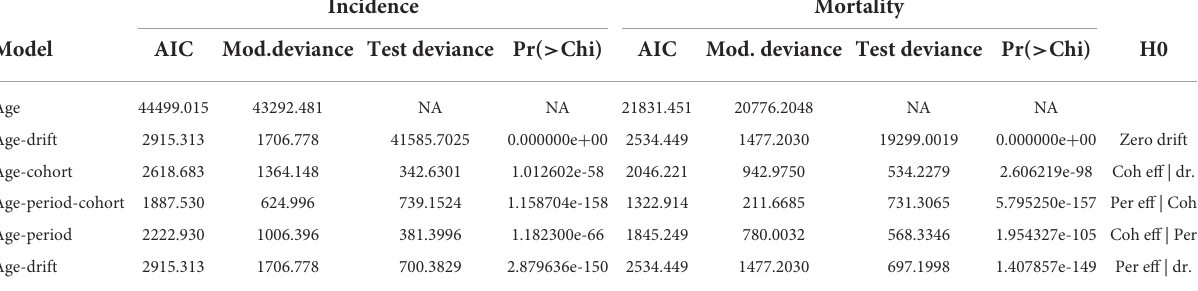
TABLE 3 Comparison of age-period-cohort sub-models for the incidence and mortality of IBD. Incidence